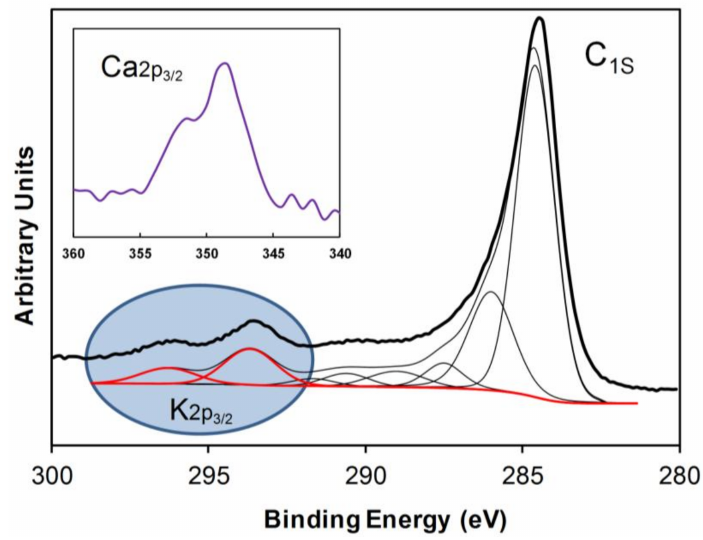
Figure 4. XPS spectra of composite